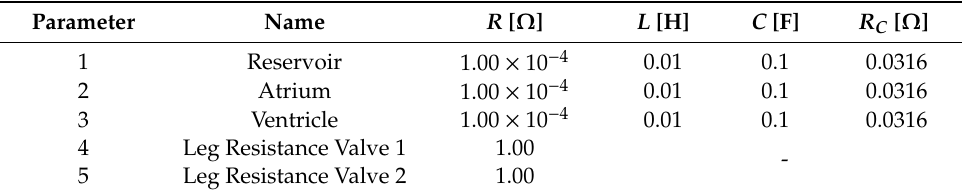
Table 3. Parameters of non-tubular